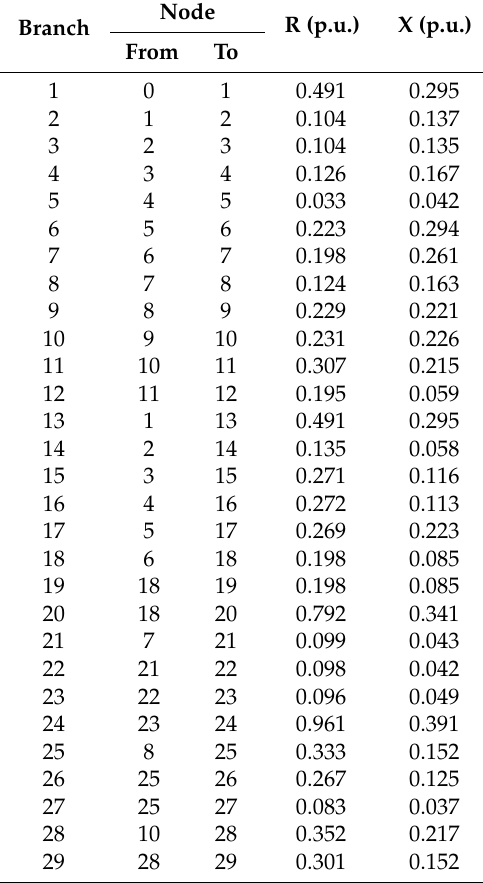
Table A1. Impedance of the